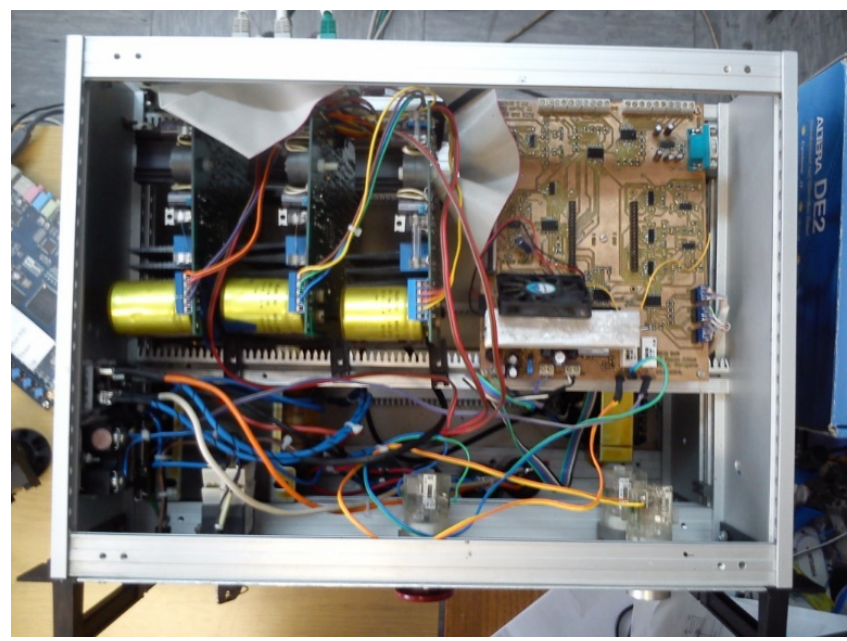
Figure 5. Controller with components.